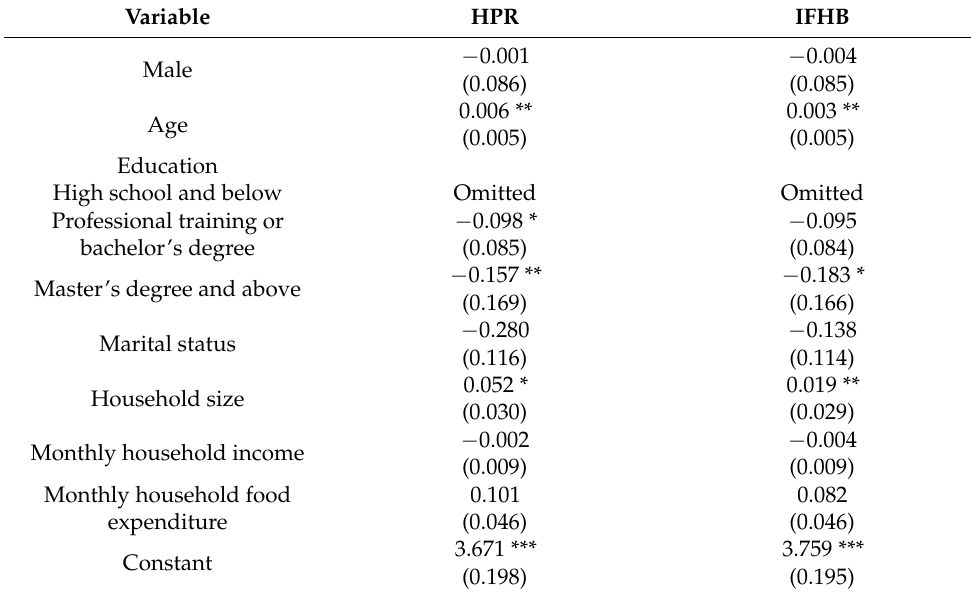
Table 11. Influence of control variables on HPR and